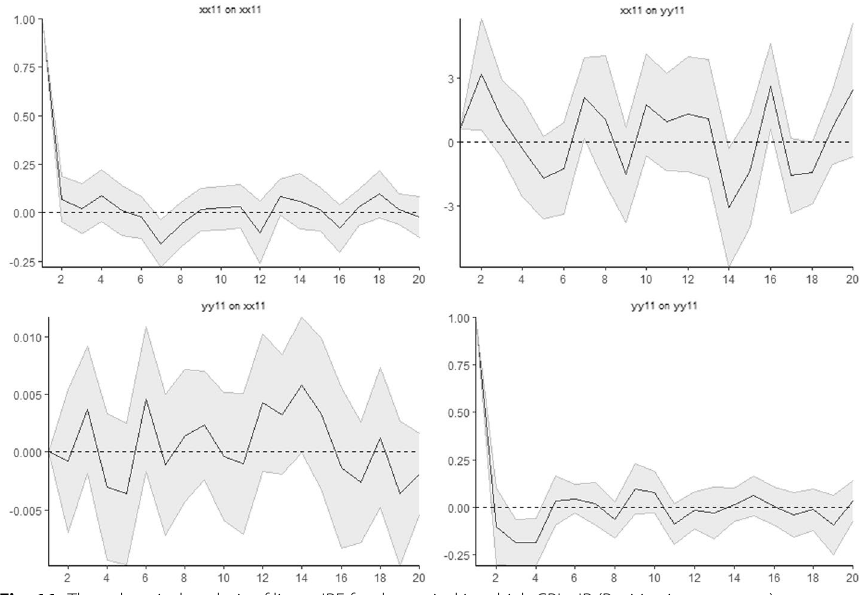
Fig. 11 The subperiod analysis of linear IRF for the period in which CPI < IR (Positive interest rates) (11.01.2018–11.29.2019)